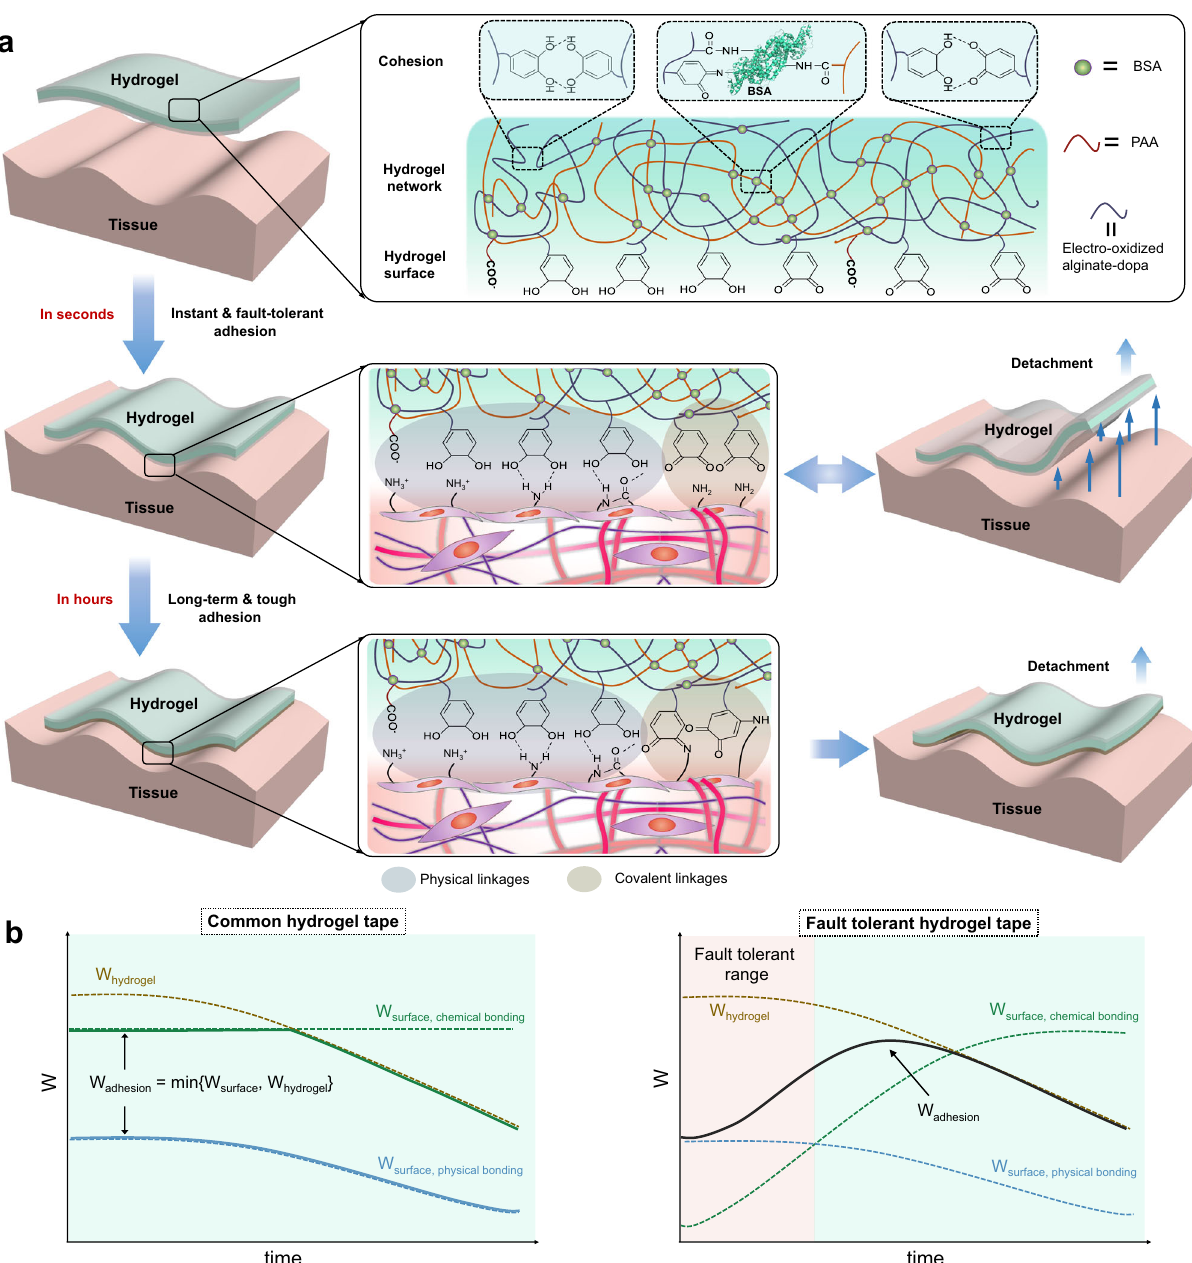
Fig. 1 Schematic illustration of the adhesion and fault-tolerant mechanism of Electro-Ox hydrogel tape. a Adhesion mechanism of Electro-Ox hydrogel tape. The hydrogel is mainly crosslinked by covalent bonds between BSA and electro-oxidized alginate-dopa or PAA formed via EDC-NHS. The conjugation between amine groups from BSA and dopaquinone generated during electro-oxidation further strengthens the hydrogel tapes. The unfolding of BSA and rupture of hydrogen bonds between dopa/dopaquinone can dissipate considerable energy and endow the hydrogel tape with high toughness. The adhesion between the hydrogel tape and tissue surface is time dependent. First, mainly non-covalent interactions (ionic interactions, cation – π interactions, and hydrogen bonds) are formed in seconds. As the reaction between amines from the tissue surface and dopaquinone in the hydrogel proceeds, the surface bonding is gradually enhanced in hours. b Comparison of the time-dependent adhesion strength of common hydrogel tapes using either physical bonding or chemical bonding for surface adhesion and the fault tolerant hydrogel tapes using a time-dependent formation of covalent bonding for surface adhesion. The overall adhesion strength ( W adhesion , solid line) depends on the lower one between the break strength of the hydrogel ( W hydrogel , dash line) and the surface bonding energy (W surface , dash line). Physical surface bonding allows to detach the hydrogels freely but cannot ensure strong adhesion. In contrast, chemical surface bonding ensures strong adhesion but is not detachable. Due to the slow formation of chemical bonds with surface, the fault-tolerant hydrogel tapes can provide strong adhesion as instant chemical bonding hydrogel tapes yet have a time window for reversible detachment, thus combine the merits of both physical and chemical bonding-based hydrogel